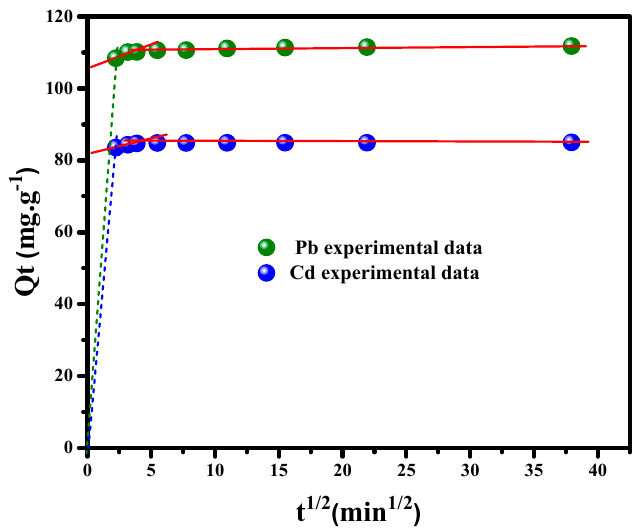
Figure 8. Intra-particle-diffusion ( q t vs. t 1/2 ) for Pb ++ /Cd ++ removal by MGCN sorbent.